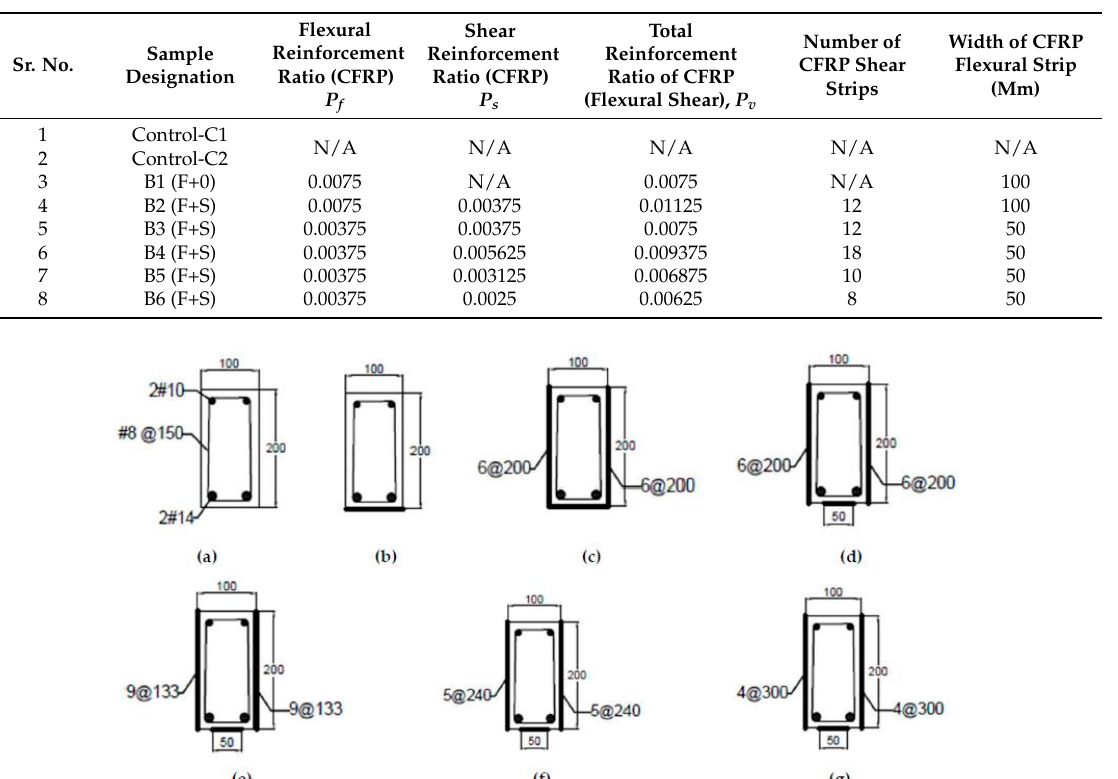
Table 1. Preliminary testing plan.